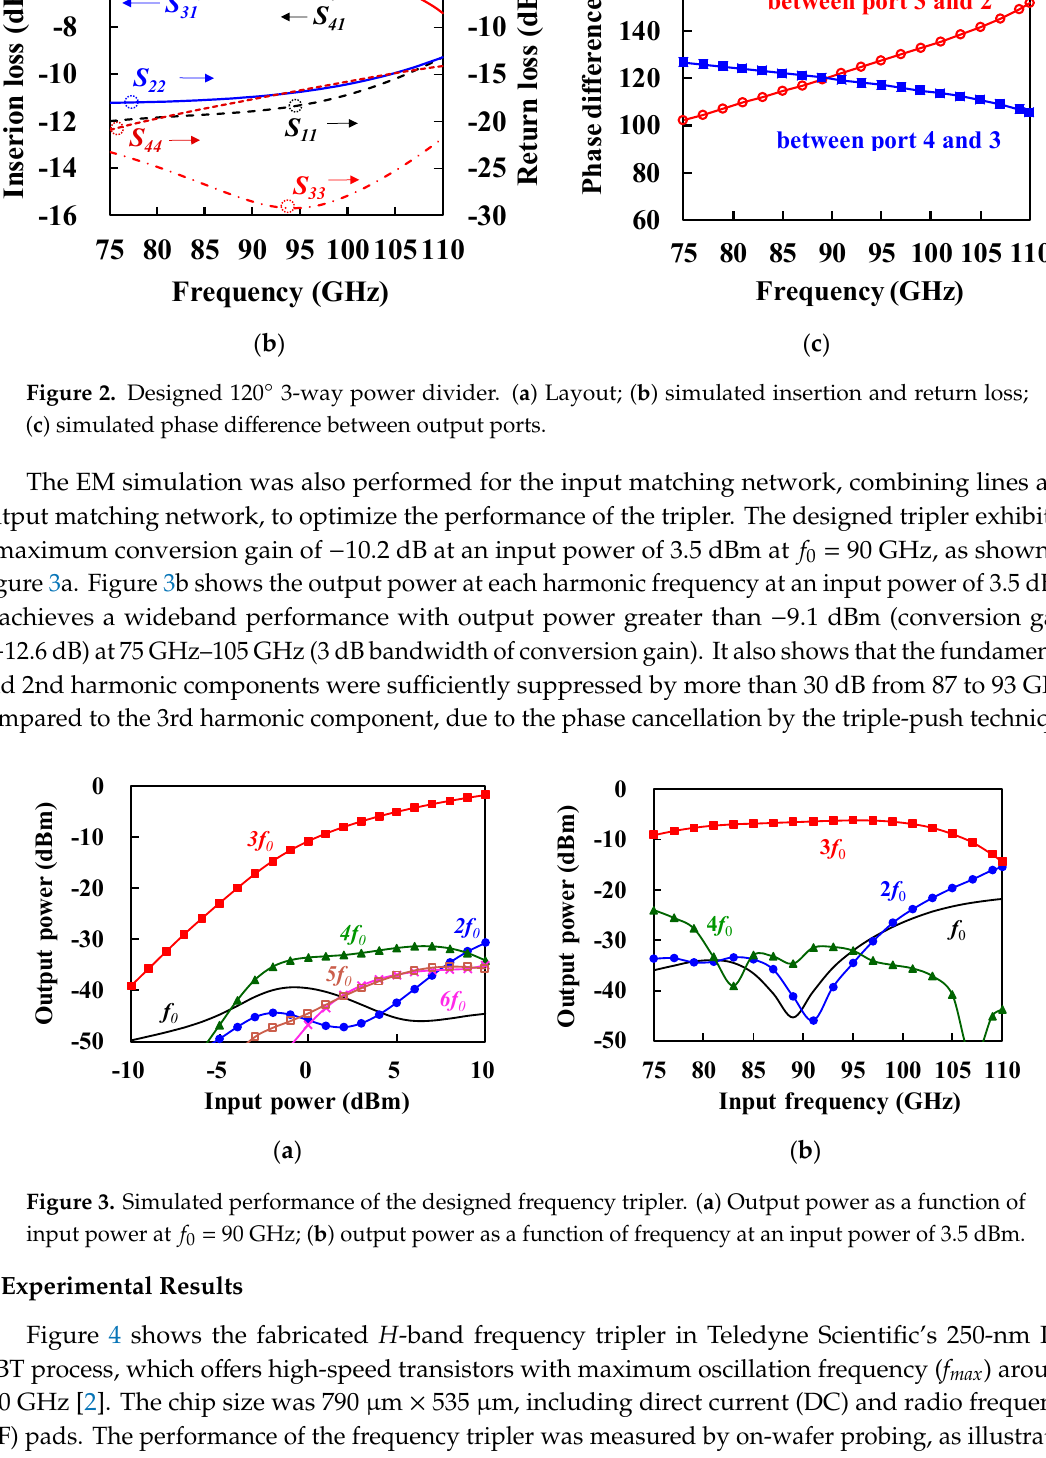
Figure 3. Simulated performance of the designed frequency tripler. ( a ) Output power as a function of input power at 𝑓 (cid:2868) = 90 GHz; ( b ) output power as a function of frequency at an input power of 3.5 dBm. meter (PM5 by Virginia Diodes, Inc. (Charlottesville, VA, USA)). The loss of each component in the measurement setup (such as the probes and waveguide sections) was measured and calibrated